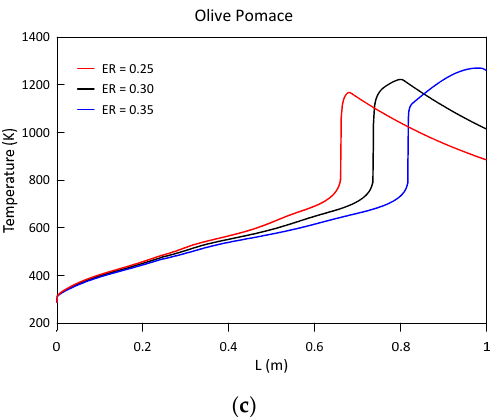
Figure 9. Temperature evolution along the reactor axis at different ER for ( a ) woodchip case 1, ( b ) hydro-char from green waste, ( c ) olive pomace.